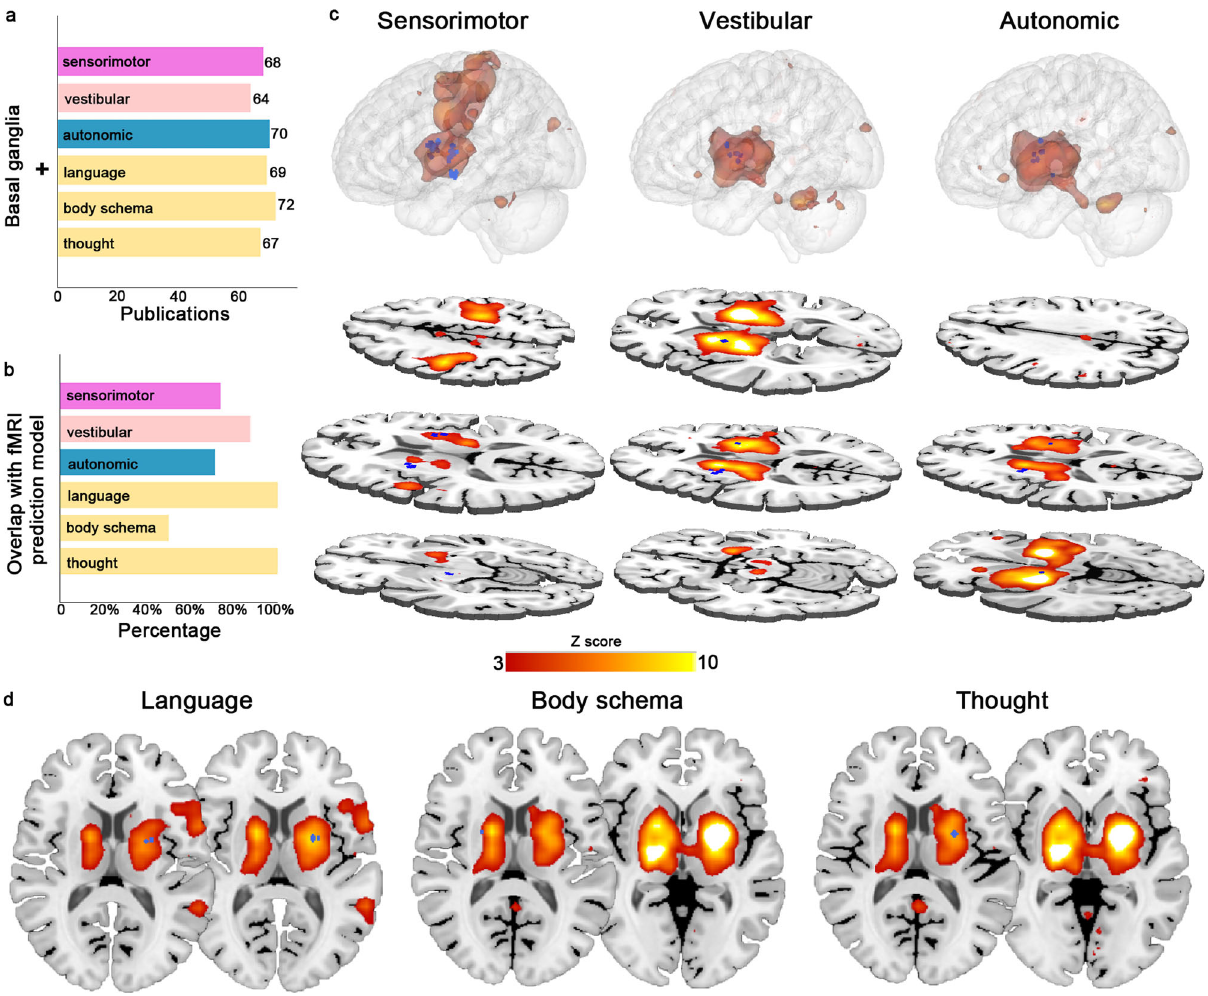
Fig. 4 Comparison with the model derived from functional neuroimaging meta-analyses. a The numbers of publications obtained from NeuroQuery using queries combining “ basal ganglia ” with sensorimotor, vestibular, and autonomic response categories and with language, body schema, and thought in the cognitive category. b The percentages of overlap between sites at which responses were elicited and the predicted functional map. c , d Illustrations of each model derived from functional neuroimaging meta-analyses (heatmap) and the locations of the sites at which stimulation elicited the corresponding responses (the blue dots). c The relationship between the predicted map and the spatial distribution of the sites at which sensorimotor, vestibular, and autonomic responses were elicited is displayed in 3D and representative slices. d Considering the complexity of cognition, within the category of cognitive responses, the sites that elicited language, body schema, and thought when stimulated are displayed separately on the predicted